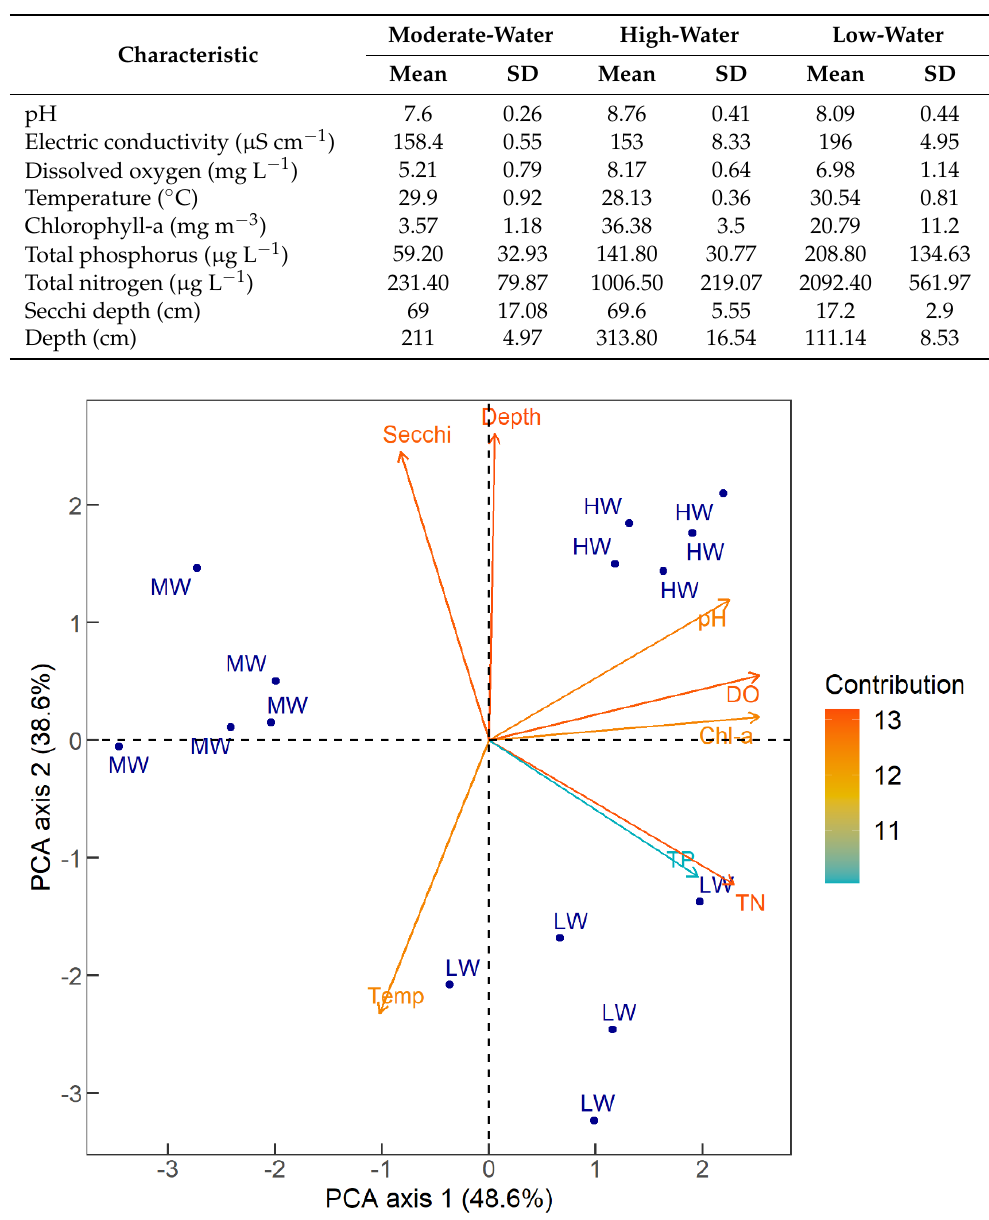
Table 2. Limnological characteristics of Lake Tempe in different hydrological periods: during the initial flooding season, when the water level was considered moderate; during the flooding season, when the water level was maximum; and during the dry season, when the water level was considered low. SD = standard deviation. Moderate-Water High-Water Low-Water Characteristic